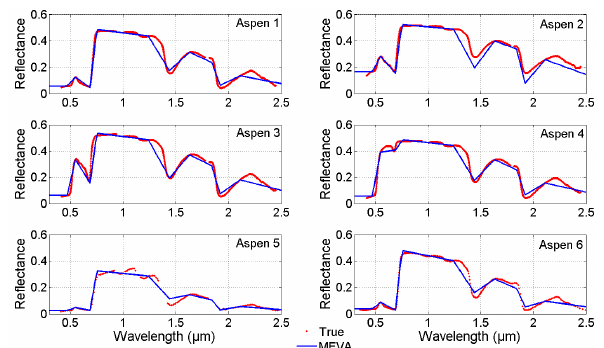
Fig. 9. In each subplot, the x-axis represents wavelength from 0.3 to 2.5µm; the y-axis represents reflectance. The solid blue lines rep- resent the MEVA results; the dotted red curves represent the “true” reflectance spectra (adopted from Arai et al., 2010) for the follow- ing six Amazonia vegetation types: veg 1: manilkara Hubert ; veg 2: couratari guianensis ; veg 3: lecythis lurida ; veg 4: genipa Amer- icana ; veg 5: miconia guianensis ; and veg 6: litter